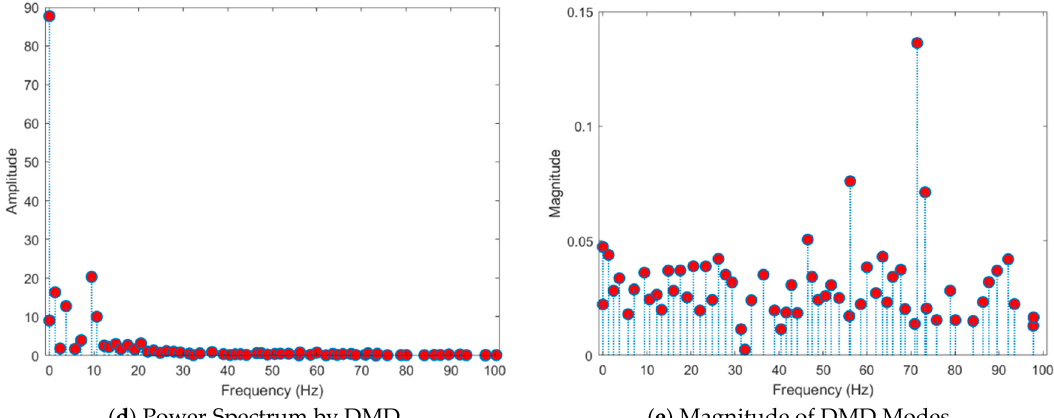
Figure 1. An ECoG signal for a specific channel including the DC shift and the HFO phenomena and three different kinds of transformations. This illustrates that the DMD method provides much clearer visibility for the HFO zone than the two other methods, fast Fourier transform (FFT) and continuous wavelet transform (CWT) ( a ) The ECoG signal from the channel 47 with 2000 Hz of sampling rate and one-second time lapse of window size. The red rectangle indicates the time frame to be used for the three types of transformations. ( b ) The power spectrum information based on FFT. ( c ) Scalogram by CWT. It characterizes the periods of increased volatility, obtaining the CWT of the data using the analytic Morlet wavelet [10]. ( d ) The power spectrum information based on DMD. ( e ) The magnitudes of DMD modes.